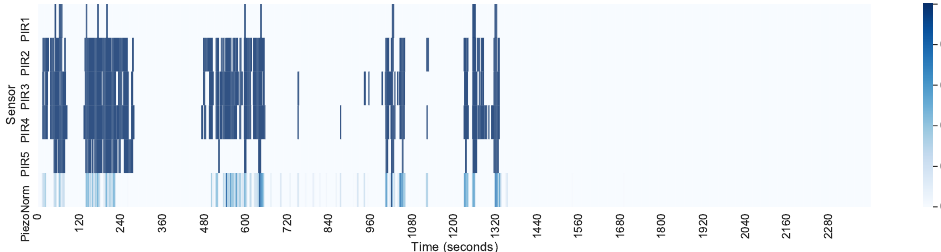
Figure 8. PIR and piezoelectric sensor activation (the first 40 min of the 8 h of